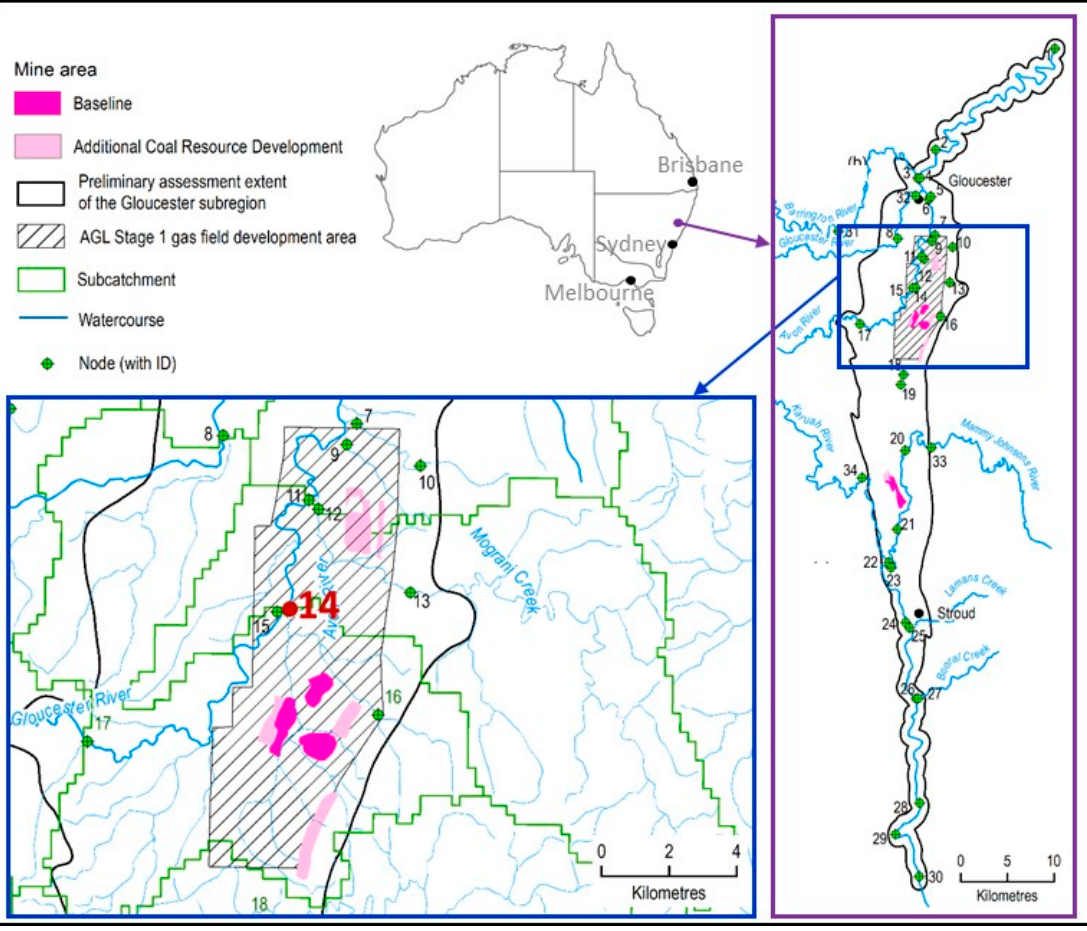
Figure 1. Map of study area showing the Gloucester sub-region, locations of proposed coal seam gas and coal resource development, and the 30 receptor or stream nodes where the modelling results are reported (adapted from [4]).